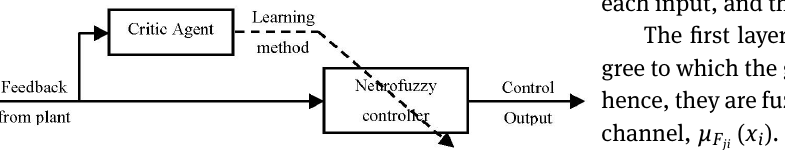
Figure 6. Structure of adaptive critic-based neurofuzzy controller. rule R j , can be viewed as a fuzzy implication by the infer- ence engine.